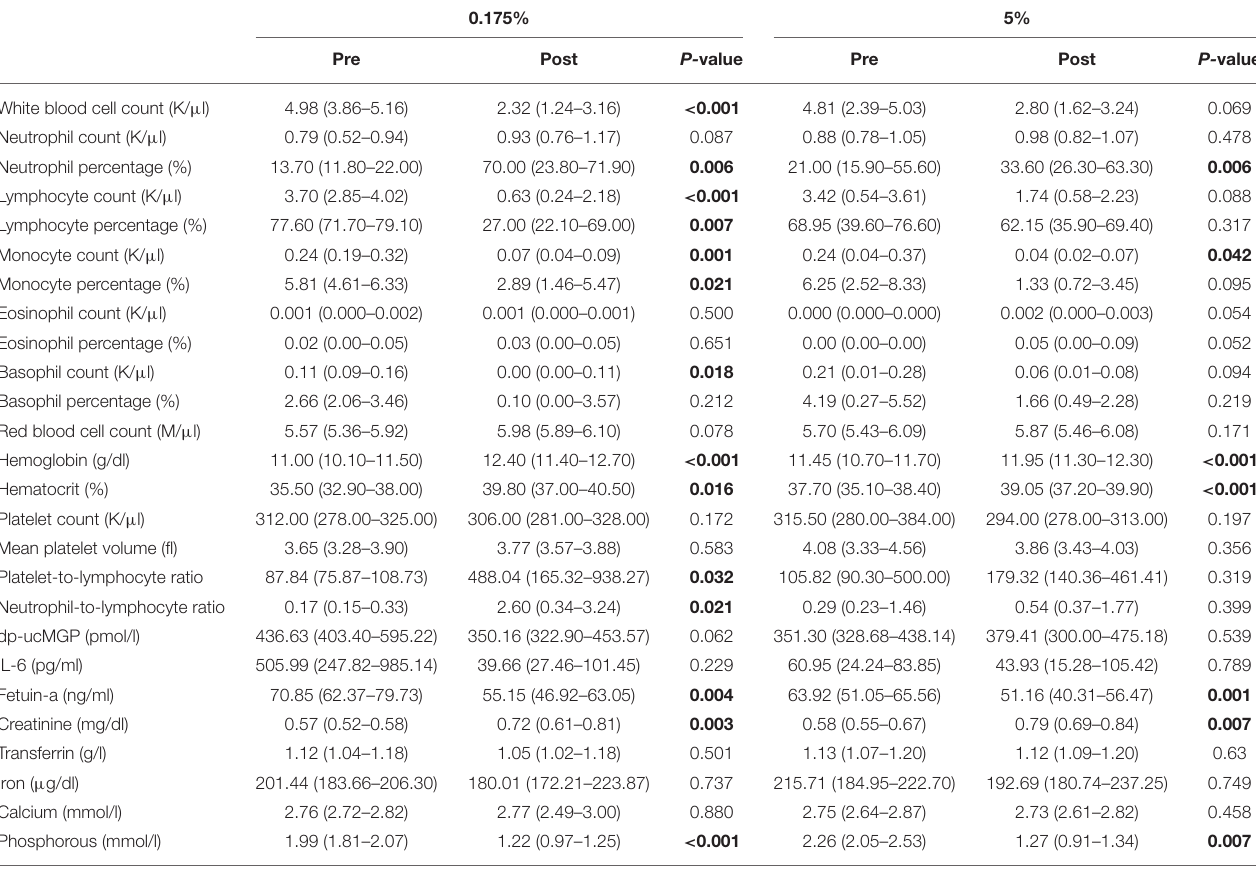
TABLE 2 | Levels of circulating biomarkers measured before (pre) and after (post) 16 weeks of PA or PA/OA-enriched diets. 0.175%